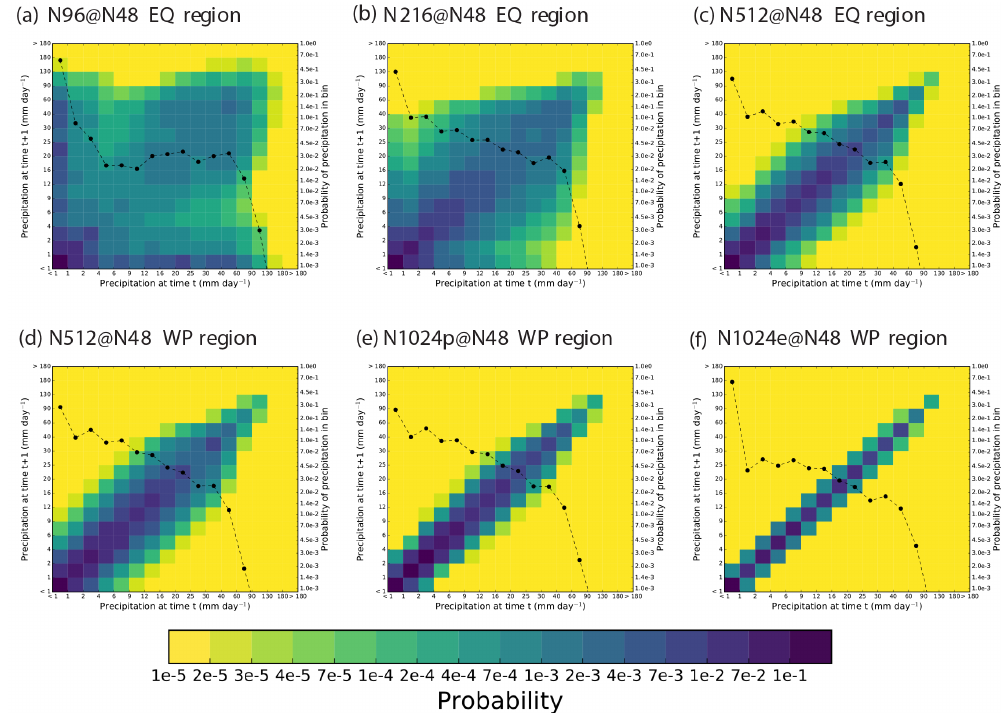
Figure 5. As in Fig. 2, but using time step rain rates that were first spatially averaged to a 3 . 75 ◦ × 2 . 5 ◦ horizontal grid (MetUM N48